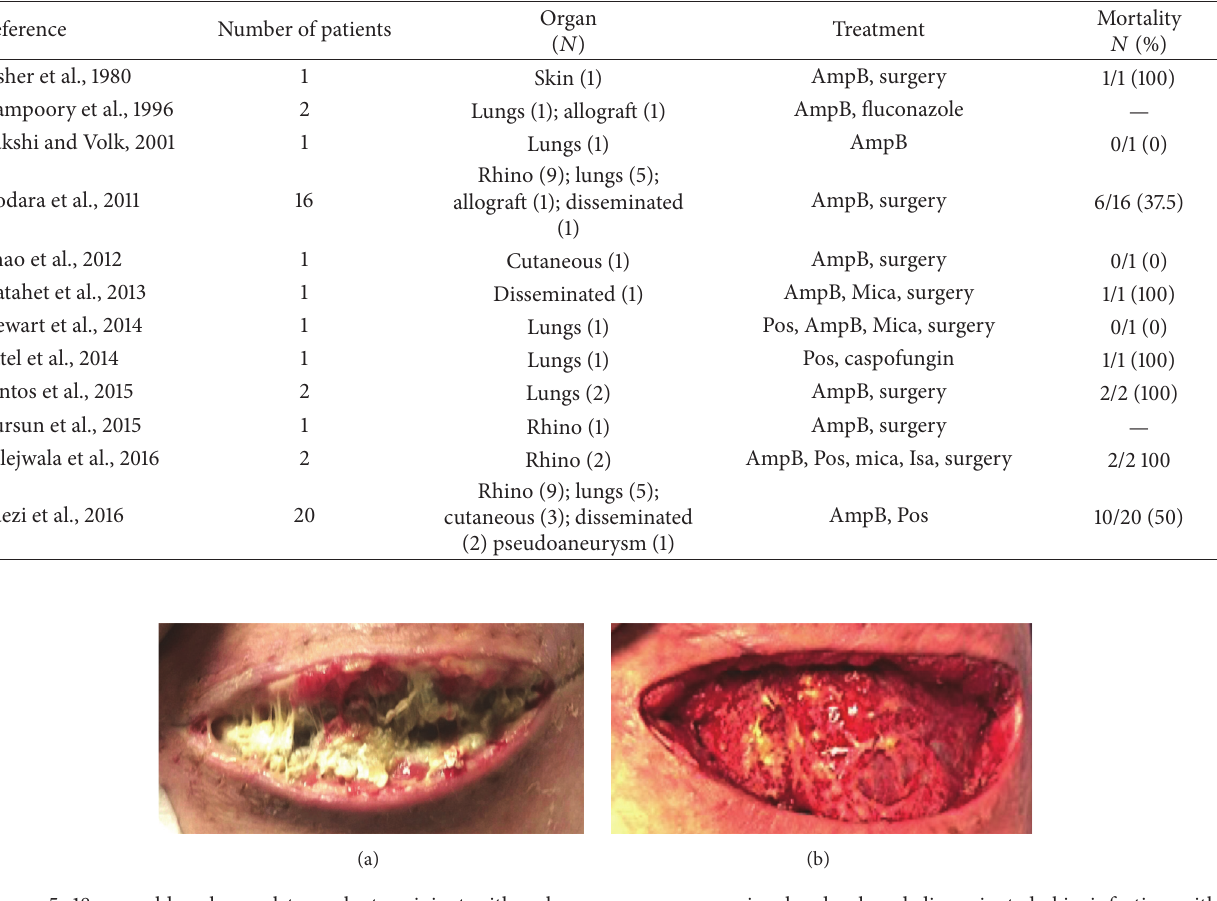
Figure 5: 18-year-old male renal transplant recipient with pulmonary mucormycosis who developed disseminated skin infection with mucormycosis at thoracotomy site (a) and following debridement